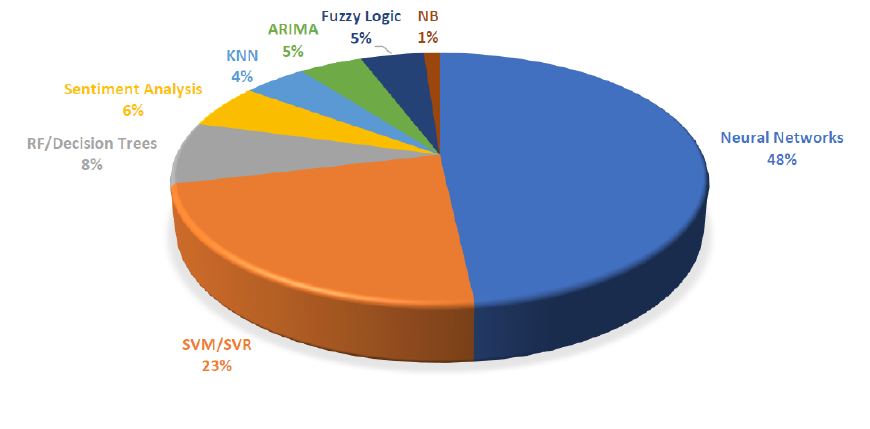
Figure 6. Papers based on references.